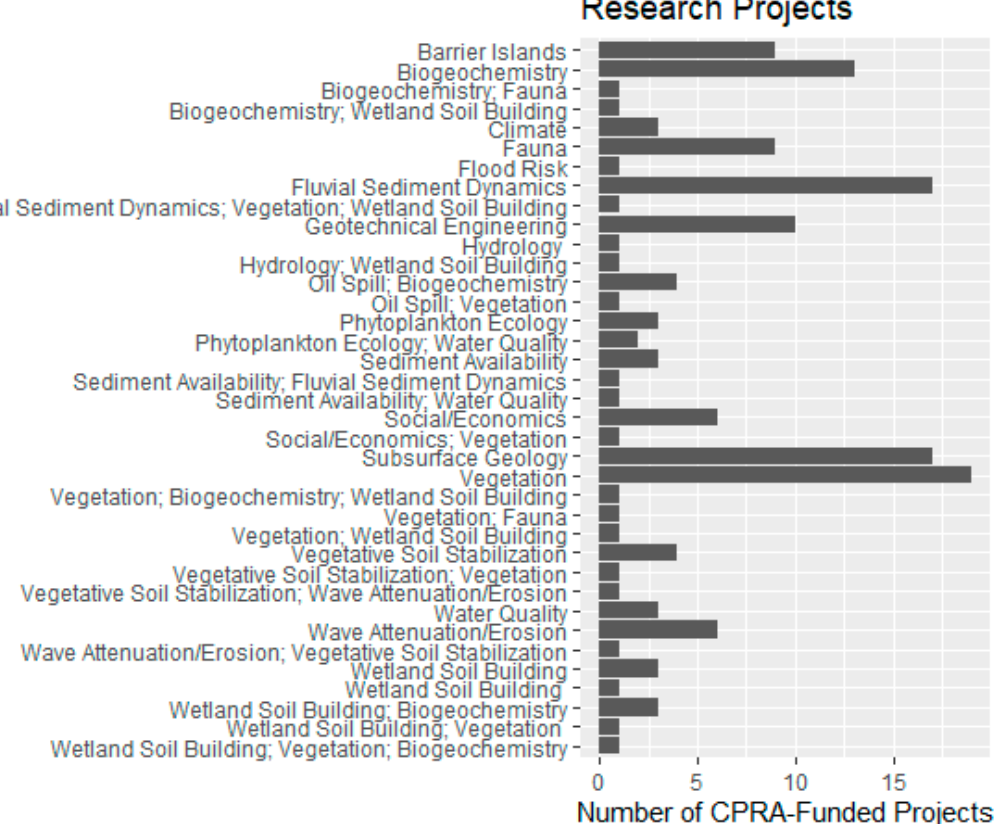
Figure 6. CPRA-funded research project topics from 2010 to March 2021. The projects do not include project-specific modeling studies or feasibility studies.